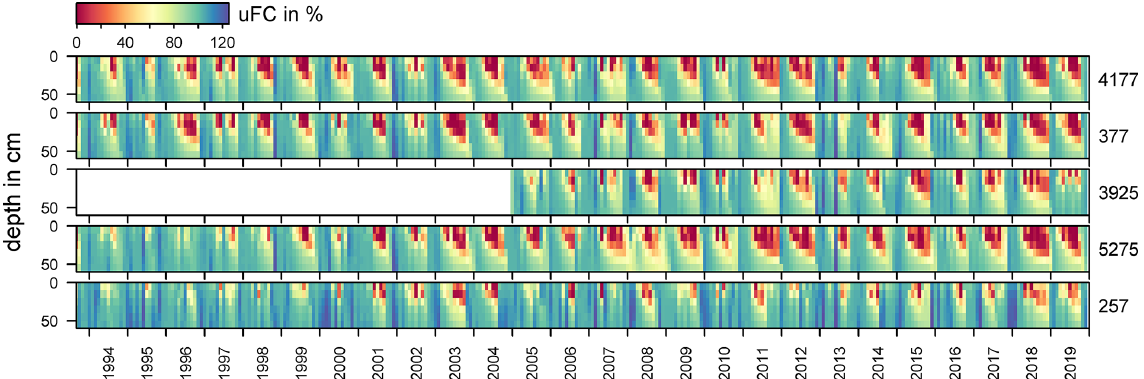
Figure A2. Monthly averages of usable field capacity calculated at five selected weather stations (DWD Climate Data Center, 2020). Val- ues were computed by the agrometeorological model AMBAV. The model calculates soil moisture under grass with sandy loam. The soil sandy loam has a wilting point of 13 volumic% and a field capacity of 37 volumic%. Further model input parameters are hourly values of temperature, dew point, wind speed, precipitation, global radiation and reflected long-wave